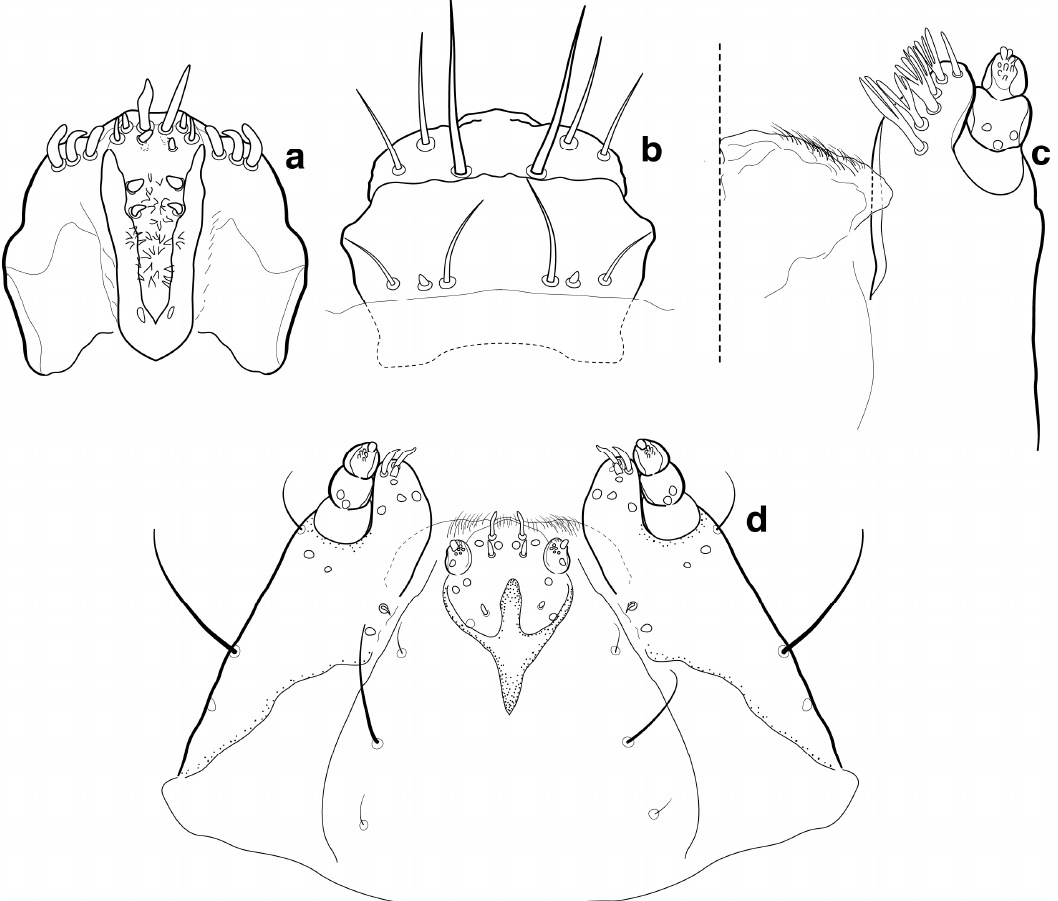
Figure 62. Dryophthorus americanus mouthparts: ( a ) epipharynx; ( b ) clypeus and labrum; ( c ) detail of hypopharynx, mala, and maxillary palp, dorsal view; and ( d ) labio-maxillary complex, ventral view.